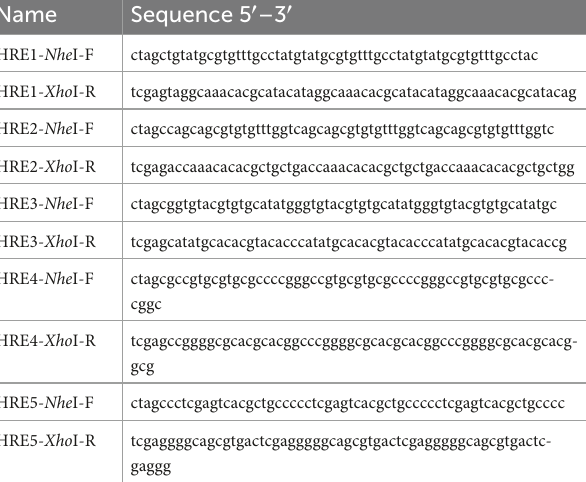
TABLE 2 Primers for annealing